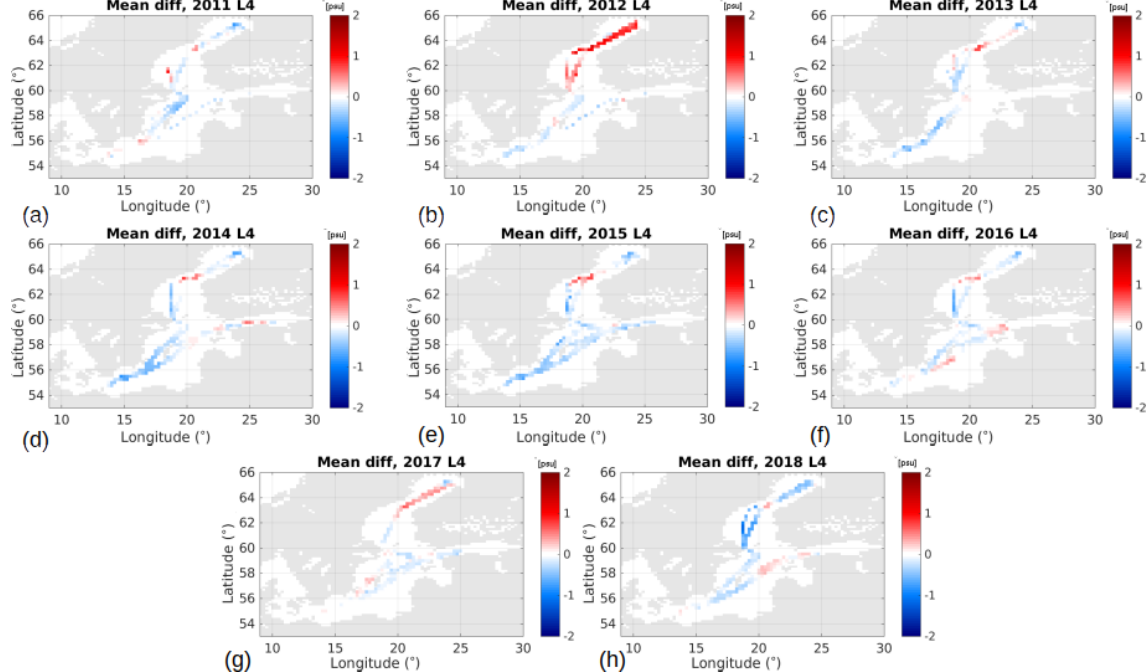
Figure 17. Comparison of L4 SSS and ferry data: spatial distribution of mean (cid:49) SSS [psu] per year (from a 2011 to h 2018).